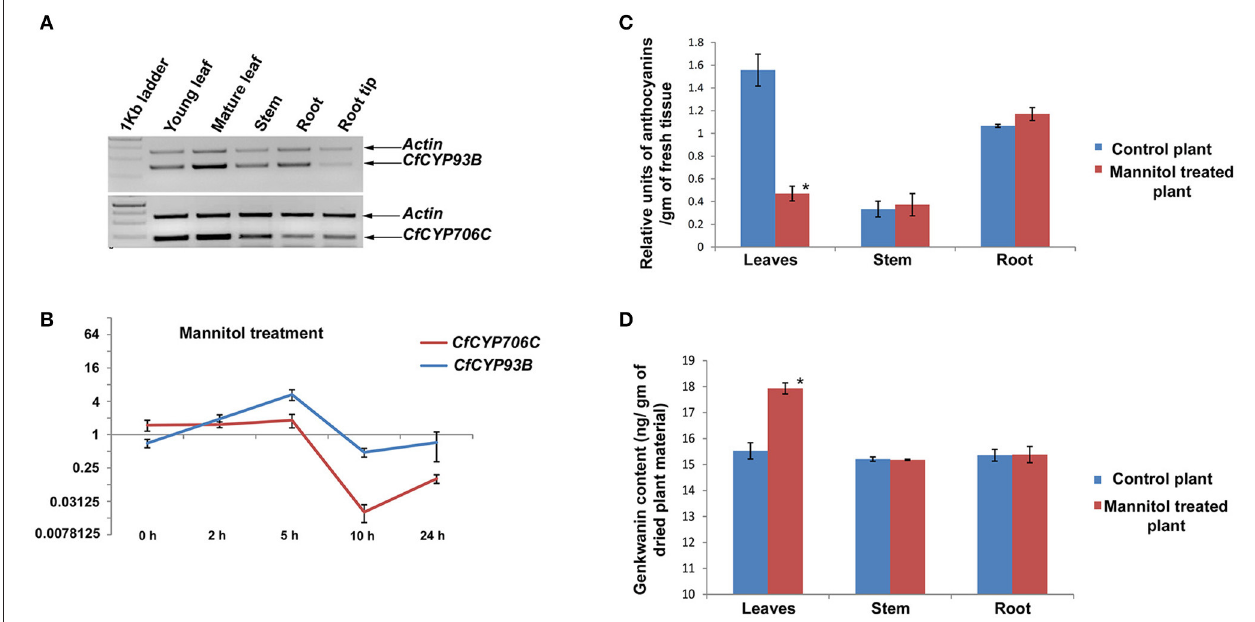
FIGURE 3 | Expression study of CfCYP93B and CfCYP706C and its correlation with genkwanin and anthocyanin content. (A) Semi quantitative RT-PCR expression study of CfCYP93B and CfCYP706C in different tissues (young leaves, mature leaves, stems, roots, and root tips) of C. forskohlii. (B) qPCR study of CfCYP93B and CfCYP706C in response to mannitol treatment at different time interval (0, 2, 5, 10, and 24 h). Actin was used as housekeeping gene. For qPCR study, p < 0.05. (C) Relative anthocyanin units in different tissues (leaves, stem, and root) in response to mannitol stress. (D) Genkwanin content in different tissues (leaf, stem, and root) in response to mannitol stress. * indicates p < 0.05.